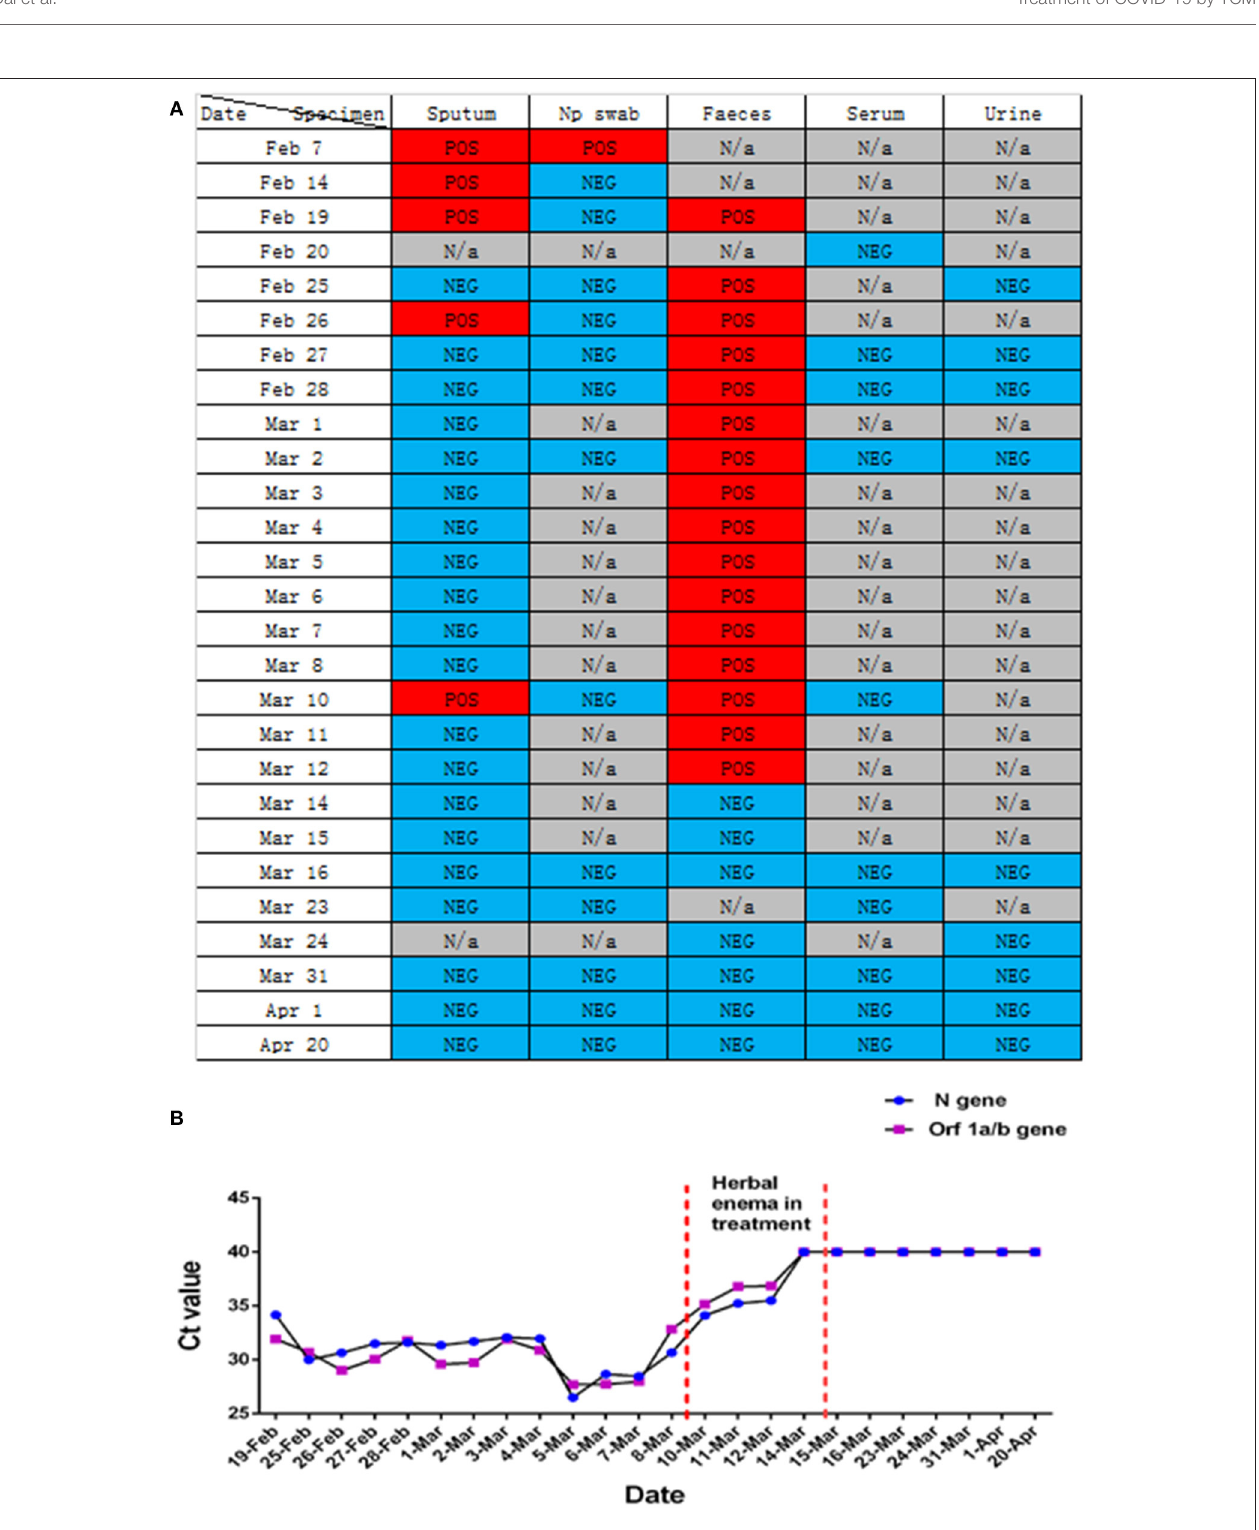
FIGURE 3 | Changes in nucleic acid detection in various patients with COVID-19. (A) Detection of SARS-CoV-2 nucleic acids in different samples of patients with COVID-19 during hospitalization. POS, Test result was positive; NEG, Test result was negative; N/a, No relevant tests were carried out. (B) Detection of SARS-CoV-2 nucleic acid in the feces of patients with COVID-19 pneumonia during hospitalization. Before February 25, 2020, the New Coronavirus 2019-nCOV nucleic acid detection kit (real-time fluorescent PCR method) provided by Shanghai Berger Biotechnology Co., Ltd. was used, and the New Coronavirus 2019-nCOV nucleic acid detection kit (real-time fluorescence PCR method) provided by Da’an gene Limited by Share Ltd. of Zhongshan University was used after February 25, 2020.